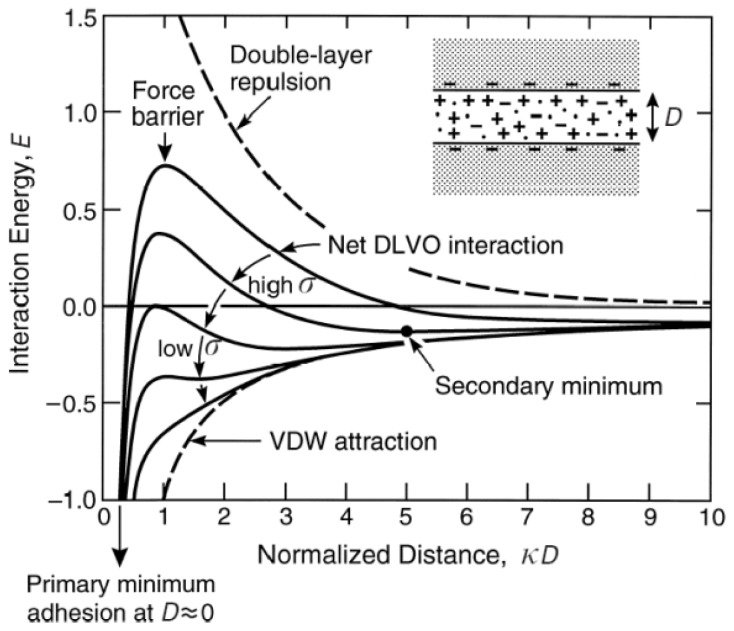
Schematic DLVO plots showing how the attractive vdW and repulsive electrostatic double-layer forces together determine the total interaction potential between two charged surfaces in aqueous electrolyte solutions at different surface charge densities σ or potentials Ψo (Reproduced by permission of Elsevier [301]).